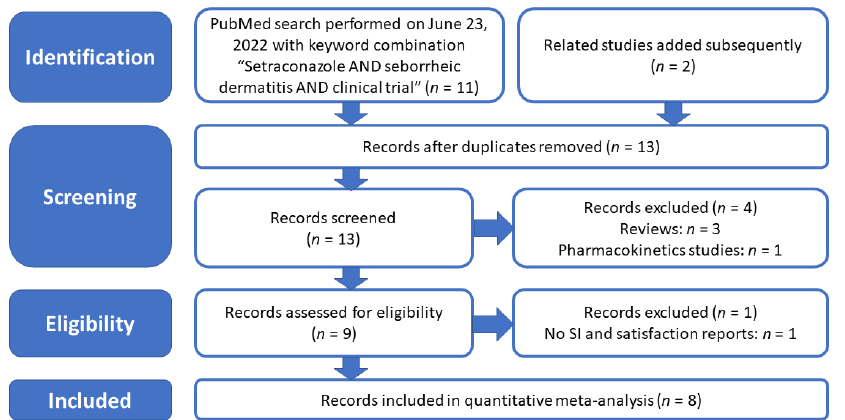
Figure 1. Retrieval and selection of publications to be included in the meta-analysis according to the PRISMA guidelines.